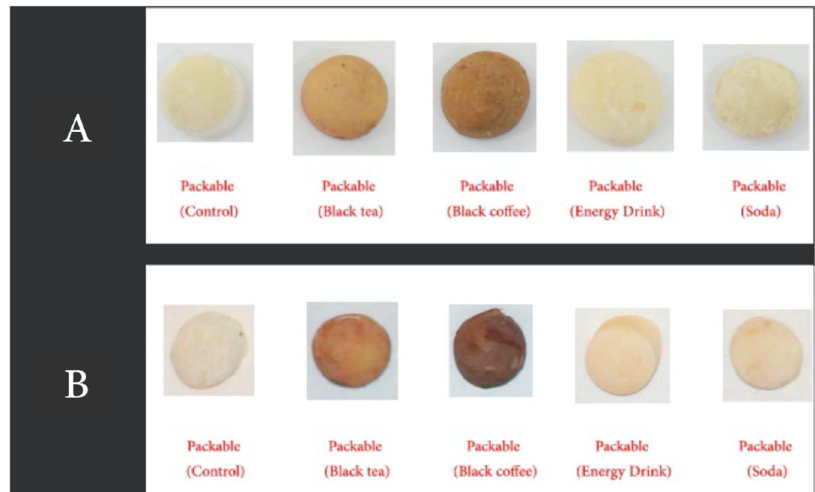
Fig. 3 Composite Speciments ready for measurements. A Composite resin (after 2 weeks). B Compositeresin (after 4 weeks).